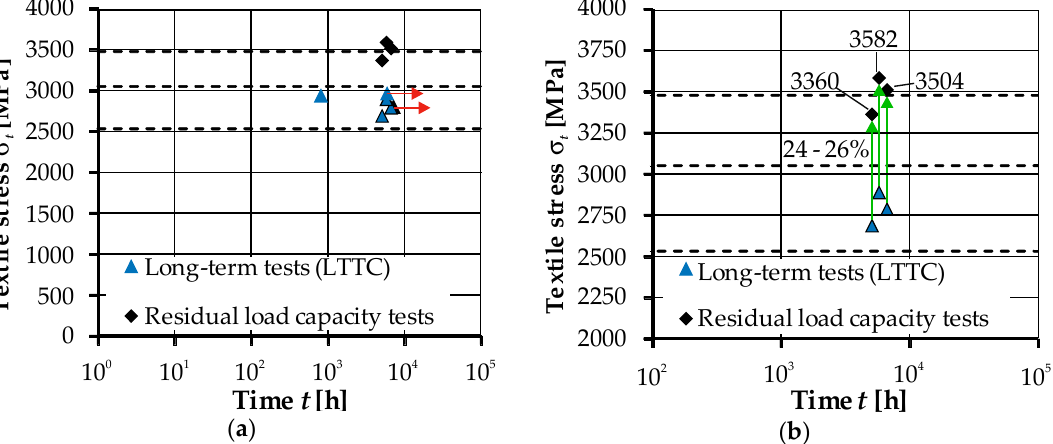
Figure 5. ( a ) Overview of the long-term durability tests; ( b ) stopped long-term durability tests and their residual capacity.